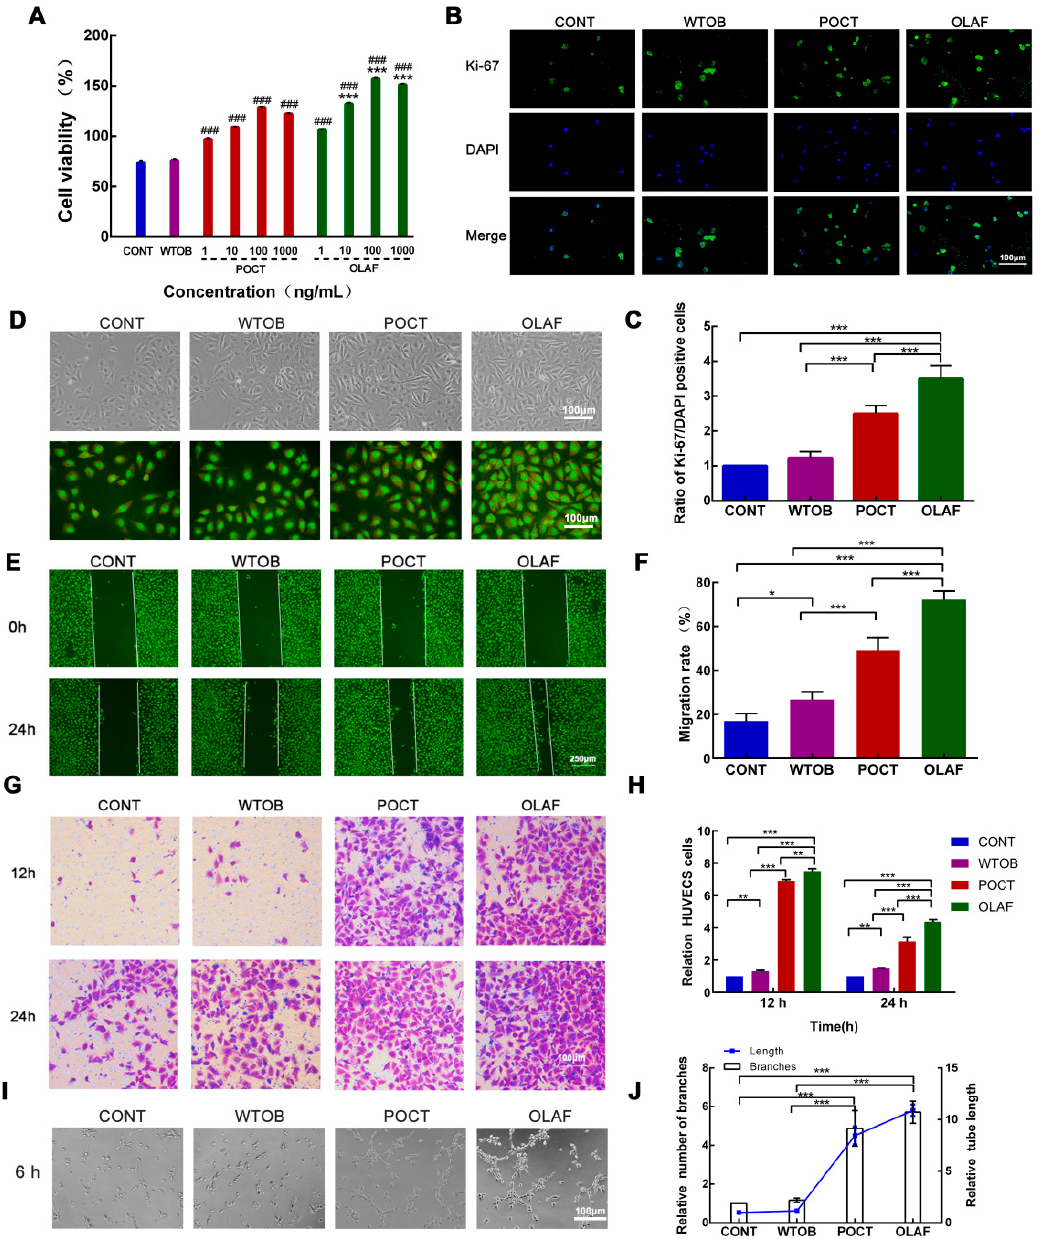
Figure 5. Effect of oleosomes fused with human fibroblast growth factor 1 (OLAF) on angiogenesis in vitro. ( A ) Cell viability assay was introduced to detect the viability of OLAF-exposed HUVECs. ### p <0.001 vs. CONT group; *** p <0.001 vs. the samples of POCT group with the same concentration. ( B ) Images of immunofluorescence staining of Ki-67-positive HUVECs in various groups. ( C ) Bar chart demonstrating the ratio of Ki-67-positive HUVECs. ( D ) Representative morphological images of unstained (first row) and acridine-orange-stained (second row) HUVEC cells in different groups. ( E ) A scratch test was executed to investigate the migration of cells exposed to OLAF. ( F ) Quantitative analysis of the cell migration rate. ( G ) A cell invasion assay was carried out to verify the invasion of the HUVECs after OLAF treatment. ( H ) Quantification results of the migration test. ( I ) The effect of OLAF on the tube formation of the HUVECs. ( J ) A statistical chart of the tube length and relative number of branches in the tube formation assay. * p < 0.05, ** p < 0.01, *** p < 0.001. Mean ± SD was employed to display all the obtained data (n =